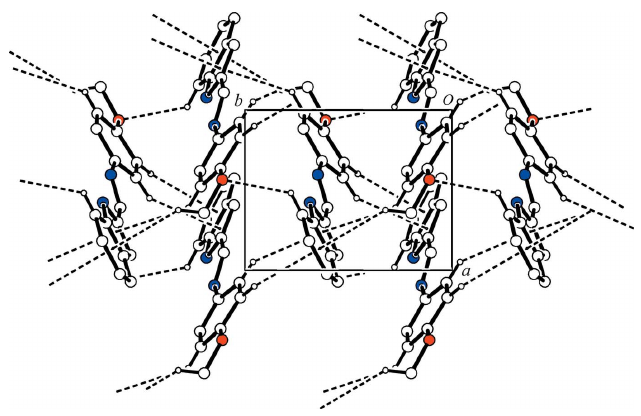
Figure 4 A packing diagram of the title compound viewed along the c axis, showing the two-dimensional network. The C—H (cid:2)(cid:2)(cid:2) O hydrogen bonds and C— H (cid:2)(cid:2)(cid:2) (cid:2) interactions are shown as dashed lines. H atoms not involved in these interactions are omitted for